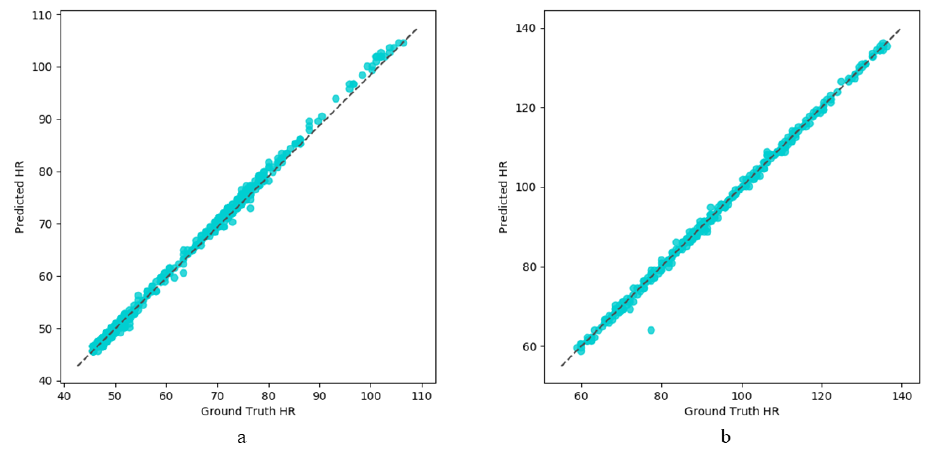
Figure 9. ( a ) scatter plot between the ground truth HR and the estimated HR on the PURE dataset; ( b ) scatter plot between the ground truth HR and the estimated HR on the UBFC